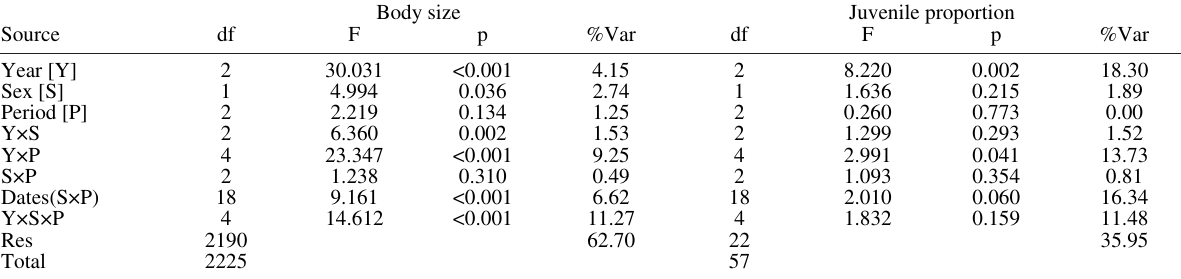
Table 1. – ANOVA test of variation in body size and juvenile proportion in the catch of Mustelus higmani captured by the artisanal fishery of Margarita Island, Venezuela, from 2006-2008. Bold denotes significant differences, %Var: variation associated at each level. Body size Juvenile proportion Source